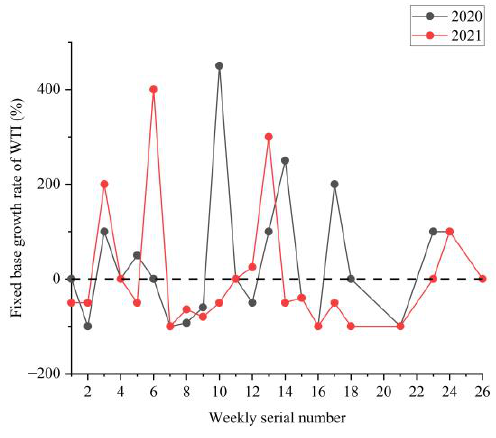
Figure 12. Fixed base growth rate of WTI.